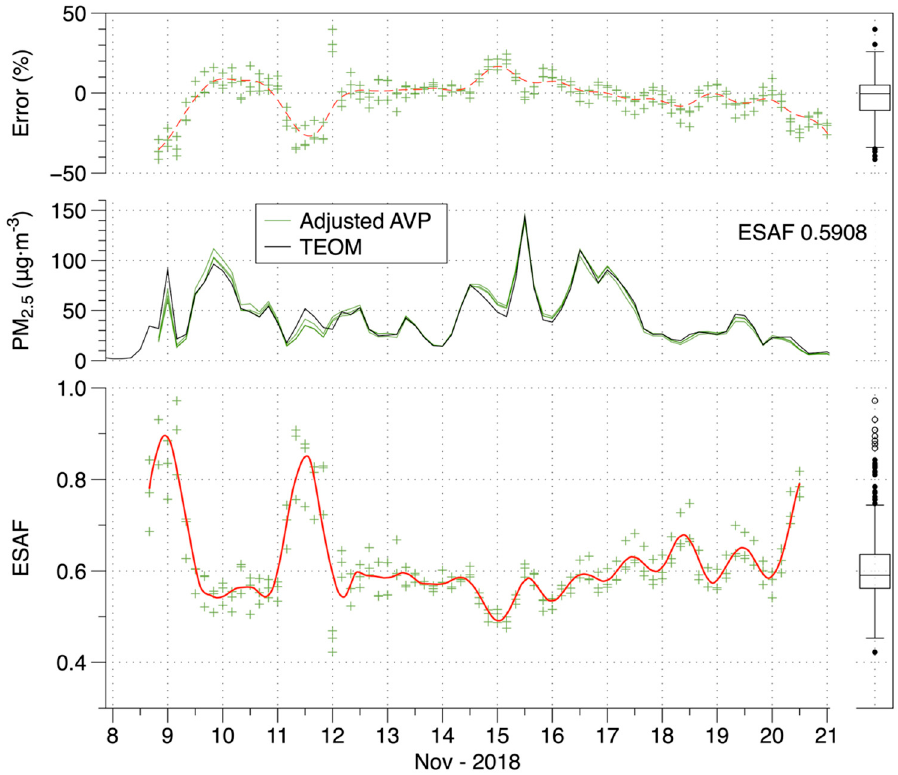
Figure 4. Event-specific adjustment factors (ESAFs), adjusted data and error of adjusted data (relative to co-located TEOM PM 2.5 ) for 4-h average AVP measurements in a naturally ventilated lab over 13 days of elevated smoke from the Camp Fire.